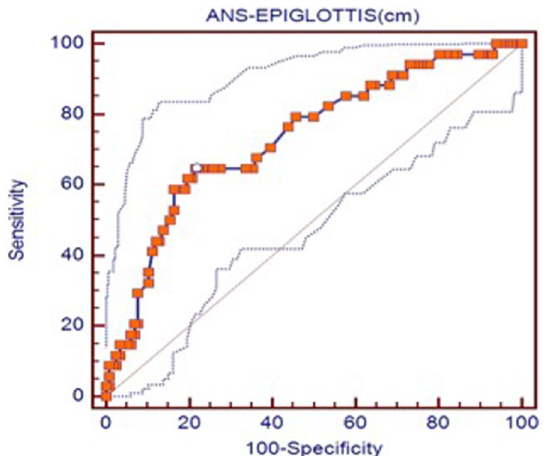
Fig. 7 ROC curve of anterior neck surface-epiglottis (ANS-E). Legend: AUC area under curve, PPV positive predictive value, NPV negative predictive value, ANS-H anterior neck surface to hyoid, ANS-E anterior neck surface to epiglottis, ANS-AC anterior neck surface to anterior commissure